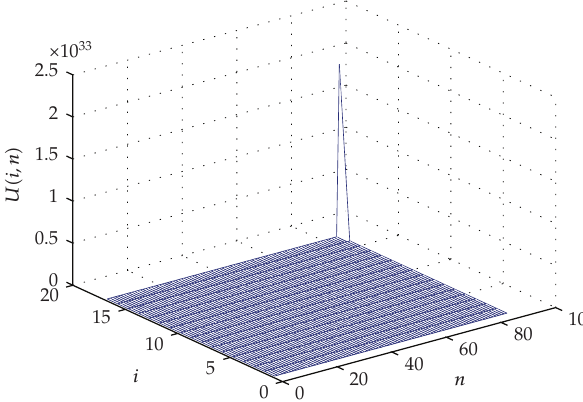
Figure 6: Evolution of the discrete solution, q (cid:2) 4, p (cid:2) 2 (cid:3) implicit scheme (cid:4)